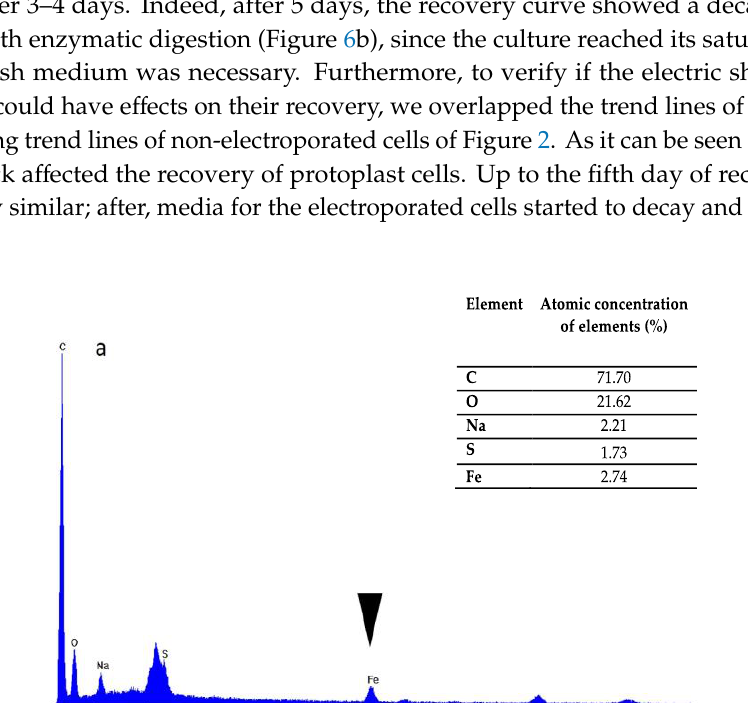
Figure 7. EDX analysis for the detection of the elemental composition of the substance. ( a ) EDX analysis of digested and transformed cells where the iron peak (arrow) is visible. ( b ) EDX analysis of glass bead-treated and transformed cells where the iron peak (arrow) is visible. ( c ) EDX analysis of control cells where the iron peak is not detected. 3. Discussion Biotechnological or genetic transformation of microalgae cells could be succeeded through a suitable cell wall perturbation, which permits the insertion of DNA/RNA or nanoparticles and simultaneously supports the normal regeneration and growth of microalgae. Microalgae cells, like bacteria, present a rigid cell wall that surrounds the plasma membrane. Besides structural properties, the cell wall is a formidable barrier that does not allow the insertion of macromolecules into the